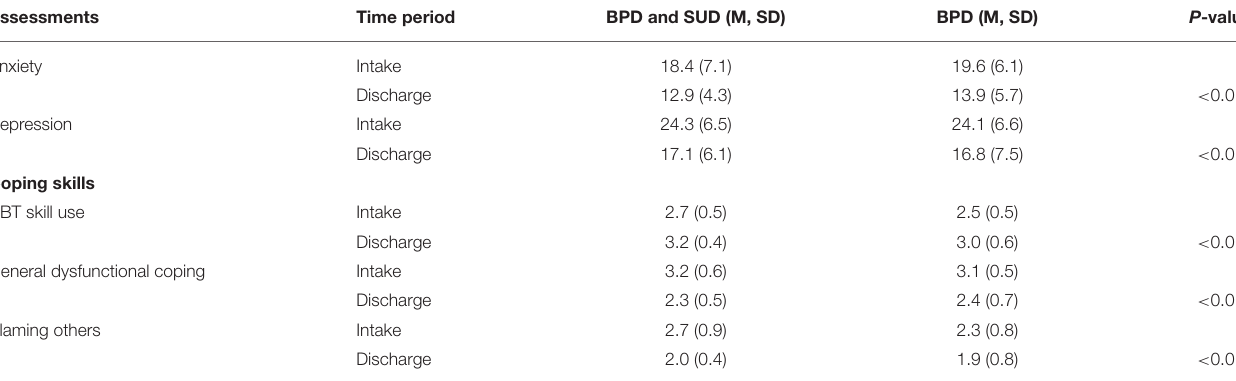
TABLE 2 | Differences across groups (BPD and SUD vs. BPD alone) in changes in clinical symptoms, coping skills and functioning after treatment.